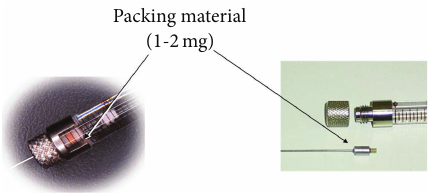
Figure 13: MEPS syringe with sorbent.